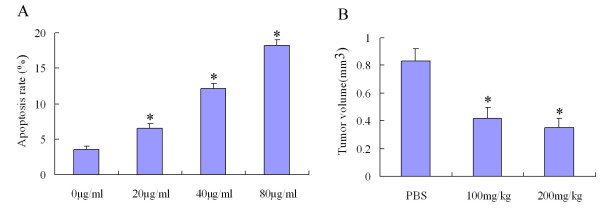
BGC-823 cell apoptosis and xenograft tumor experiment. A. Astragalus saponins induced apoptosis in BGC-823 cells. Cell apoptosis was analyzed by flow cytometry. Statistically significant (*p < 0.05)increases in annexin V + apoptotic cells were observed in Astragalus saponins–treated BGC-823 cells compared to controls. Data are presented as the mean of triplicate experiments. B. BGC-823 cell xenograft tumor experiment. Injection of Astragalus saponins inhibited tumor growth in a BGC-823 xenograft model compared with the blank control group. *Significant difference (p < 0.05).